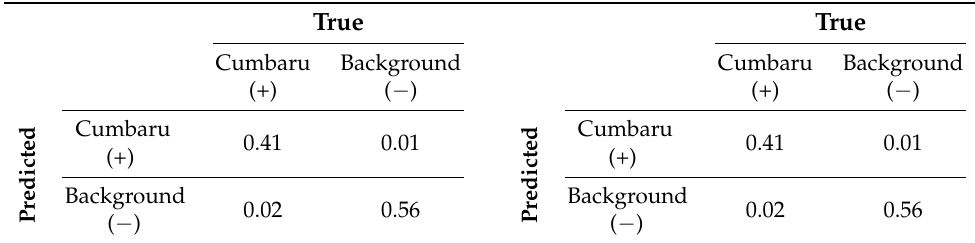
Table A3. Confusion matrix for the FC-DenseNet without CRF (left) and with CRF (right). The values are normalized by the total of pixels.